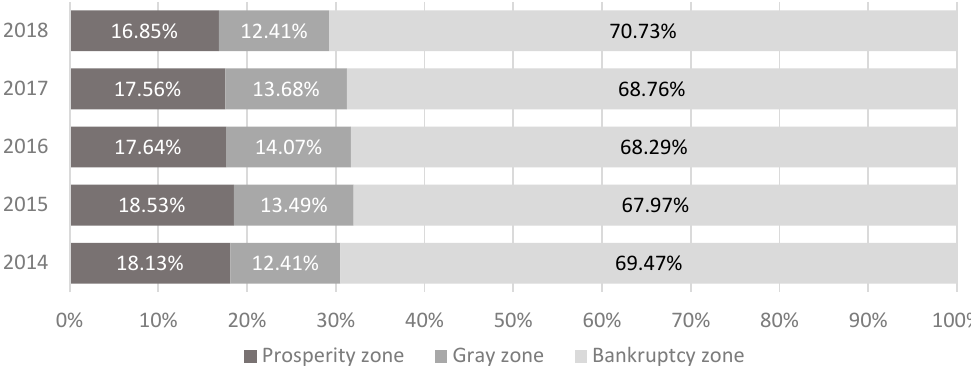
Figure 5. Financial performance of businesses with negative equity based on Altman's Z-score.